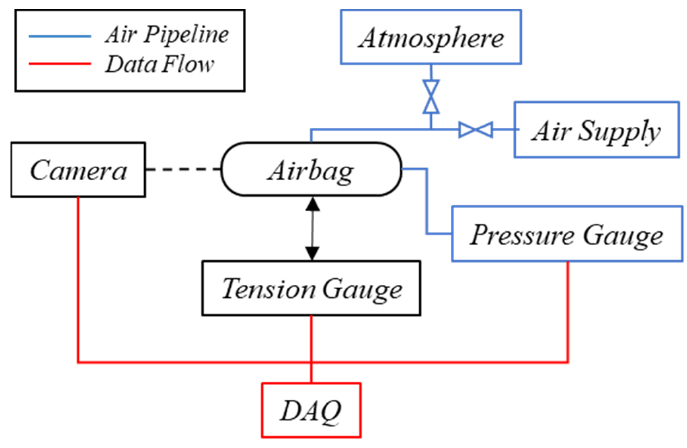
Figure 5. Block diagram of air fl ow and data fl ow.